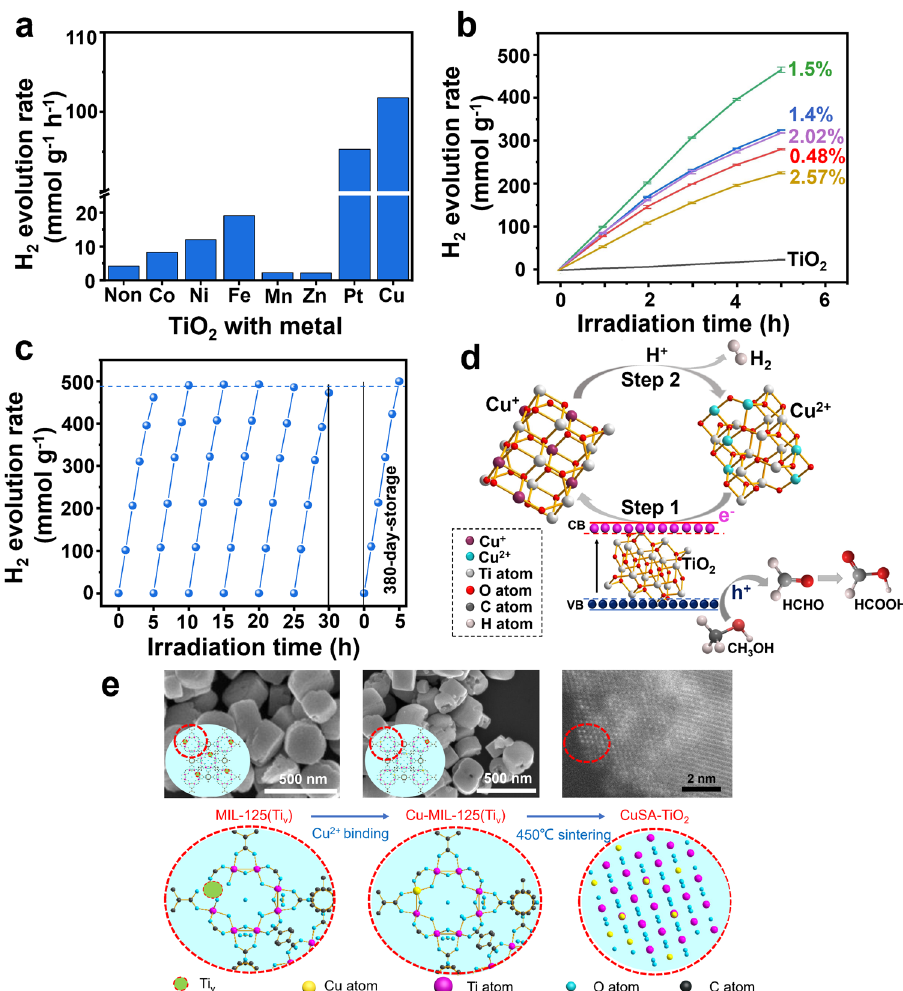
Fig. 1 Photocatalytic H 2 evolution performance and the formation of Cu SAC in the Ti lattice of TiO 2 . The photocatalytic H 2 evolution rate of ( a ) TiO 2 (non) and M-TiO 2 derived from M-MiL-125(Ti v ). b TiO 2 and TiO 2 loaded with different ratios of Cu SACs. c The photocatalytic activity of the ca. 1.5 wt% CuSA-TiO 2 for six cyclic water splitting experiments and the last run is the activity of the sample after storing in the lab for 380 days. d The photocatalytic H 2 evolution mechanism on 1.5 wt% CuSA-TiO 2 . e The corresponding schematic representation of the formation of copper SAC in the Ti lattice of TiO 2 , together with the related